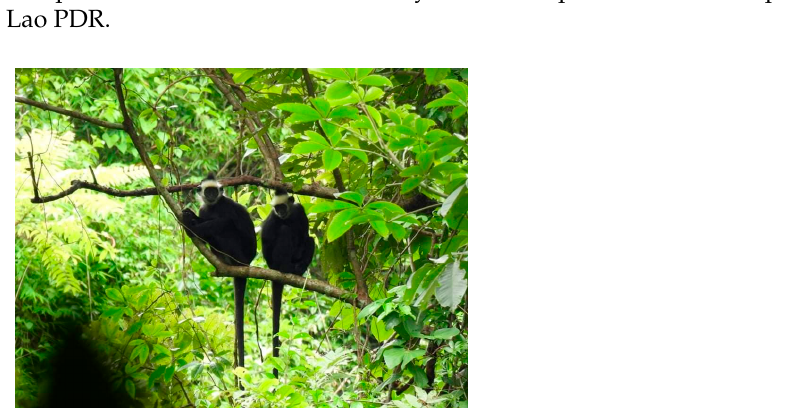
Figure 1. Individuals of the Laotian langur Trachypithecus laotum at the study area.